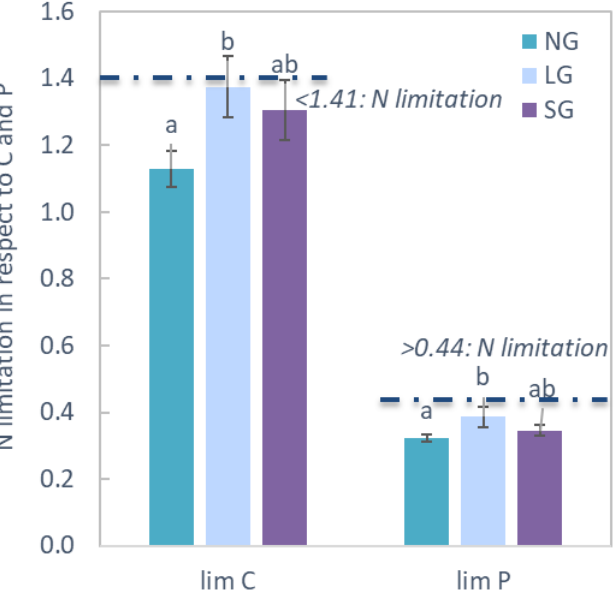
Figure 8. Soil N limitation with respect to C (lim C) and P (lim P) determined as the ratio between activities of enzymes of N cycle with β -glucosidase and acid phosphatase, respectively (mean ± standard error). Significant differences between management types are indicated by letters at p < 0.05. Dashed lines indicate the limitation threshold of N in respect to C and P.